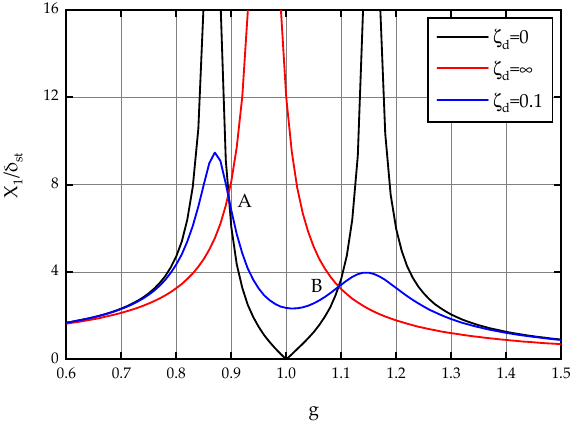
= μ= Figure 3. Dynamic amplification for f = 1, µ = 1/4. Figure 3. Dynamic amplification for 1 f , 1/ 4 . The roots of Equation (20) are denoted g A2 and g B2 and correspond to the fixed points ζ The optimal value of should make the dynamic amplification factor of the two d in Figure 3. The ordinates of the two fixed points can be obtained by substituting g A and fixed points reach the maximum. Substituting Equation (21) into Equation (19) and differ- g B into Equation (19), respectively. When the two ordinates are equal, the control result of entiating g , we can obtain the slope of the curve. By making the slope of point A equal the TMRW is optimal. This leads to to the slope of point B, the damping ratio is determined as